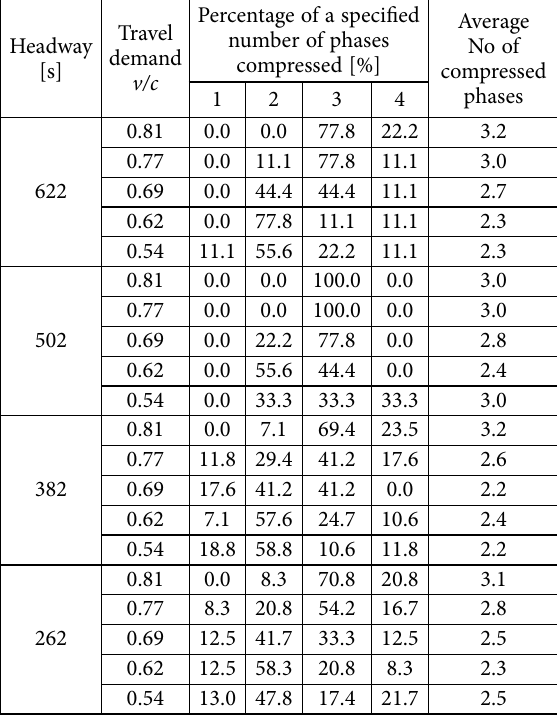
Table 5. Number of phases